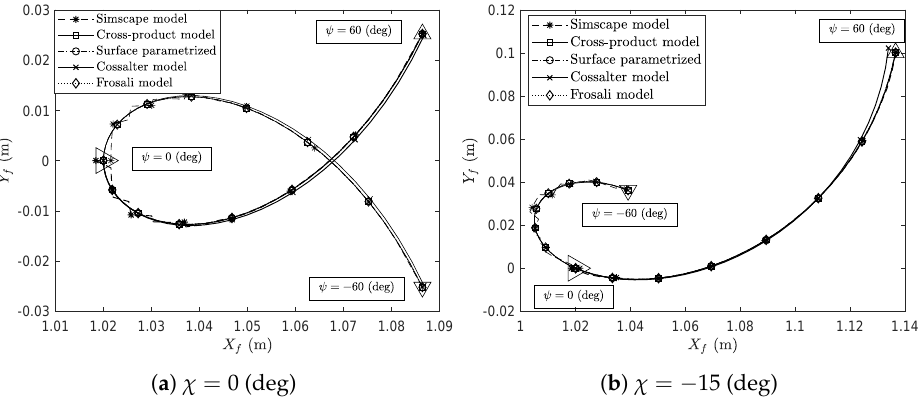
Figure 10. Front wheel contact point trajectory for a rotation of the vehicle handlebars in the range [ − 60,60 ] (deg). ( a ) presents the trajectory of the contact point for a constant roll angle of the rear frame equal to zero. ( b ) presents the trajectory of the contact point for a constant roll angle of the rear frame equal to χ = − 15 (deg). The marker (cid:66) represents the position of the contact point when the steering angle is zero. The markers (cid:79) and (cid:77) indicate the points corresponding to − 60 (deg) and 60 (deg),